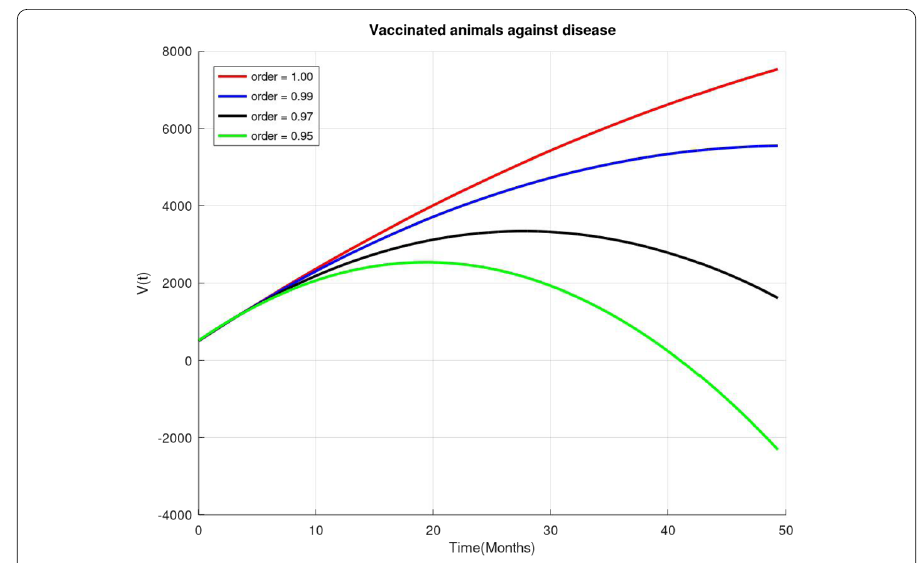
Figure 5 An illustration of the total number of vaccinated animals V ( t ) for different orders (cid:2) = 1, (cid:2) = 0.99, (cid:2) = 0.97, and (cid:2) = 0.95 during 50 months